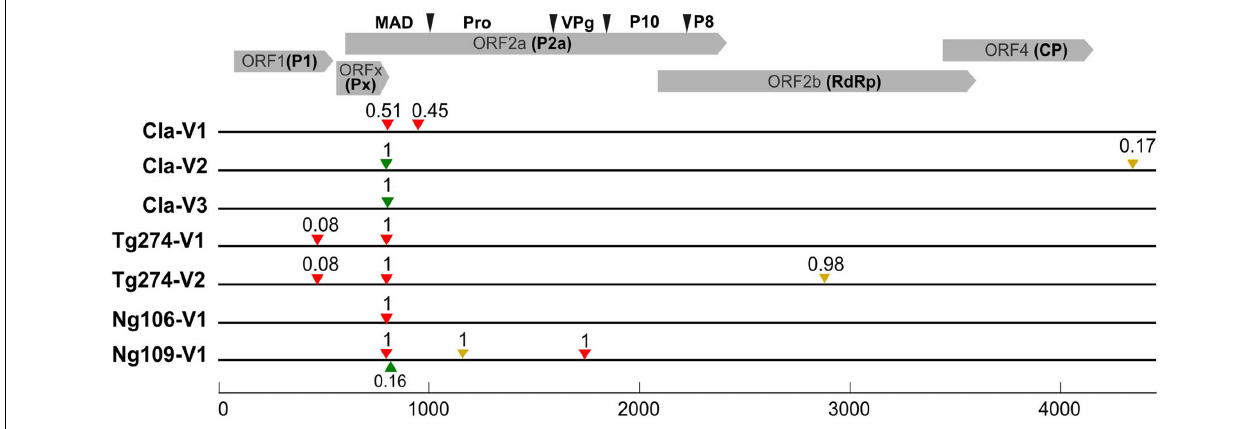
FIGURE 2 | SNPs observed in RB samples from infected Tog7291 plants. The virus full-length sequences were obtained by Illumina technology. SNPs were detected by LoFreq after mapping reads on the control sequence of the corresponding isolate. Synonymous SNPs or SNPs in non-coding regions are represented by yellow triangles, non-synonymous SNPs by red triangles, and SNPs that are non-synonymous for polyprotein P2a and synonymous for the Px protein by green triangles. The frequencies of the variants are indicated above the triangles. A nucleotide scale is given in the lower part of the figure. The upper part of the figure indicates the positions of the ORFs and proteins of the RYMV genome. For polyprotein P2a, the positions of the putative cleavage sites between the membrane anchor domain (MAD), the protease (Pro), the VPg and the homologs of SeMV proteins P8 and P10 were determined according to Nair and Savithri